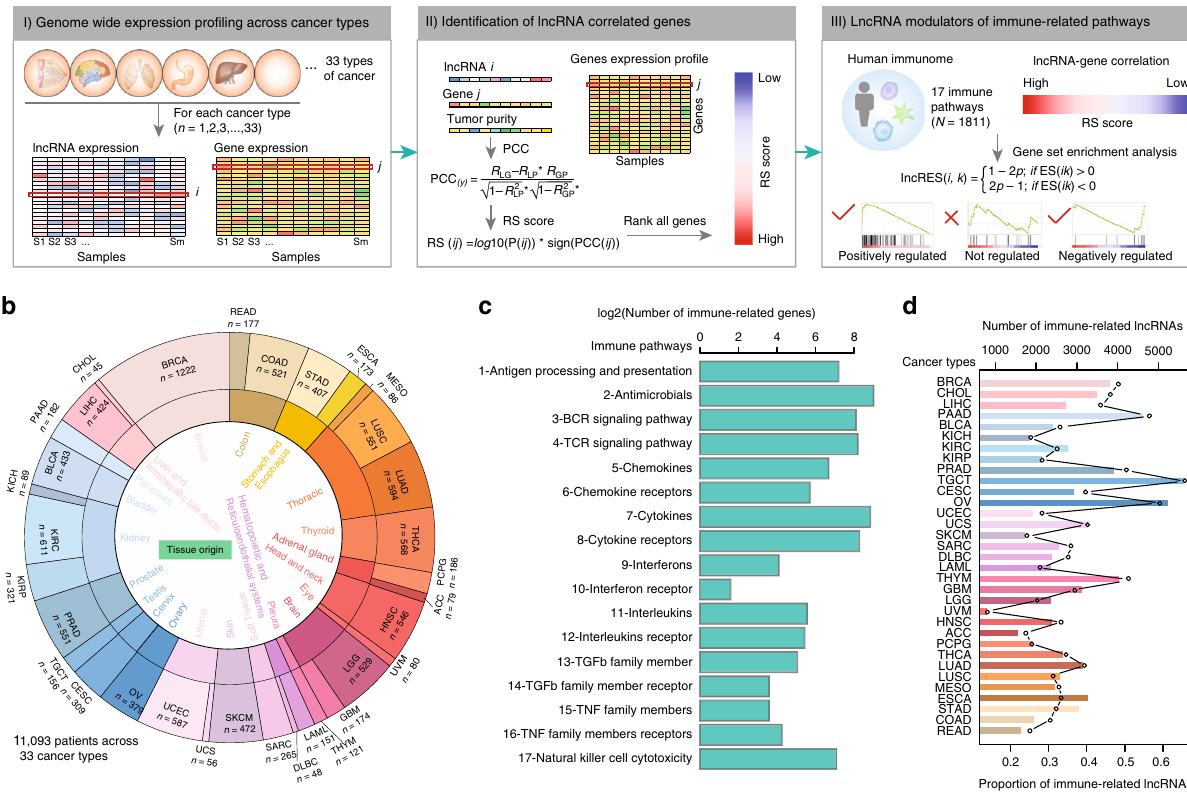
Fig. 1 Identi fi cation of immune-related lncRNAs across cancer types. a Schematic illustration of three steps of ImmLnc for the identi fi cation of lncRNA regulators. b The number of patients in each cancer type. Cancers with similar tissue origin are grouped together. c The number of genes in 17 immune- related pathways. d The number of immune-related lncRNAs identi fi ed in each cancer type. The top y -axis shows the number of lncRNAs and the bottom y -axis shows the proportion of lncRNAs. Source data are provided as a Source Data fi